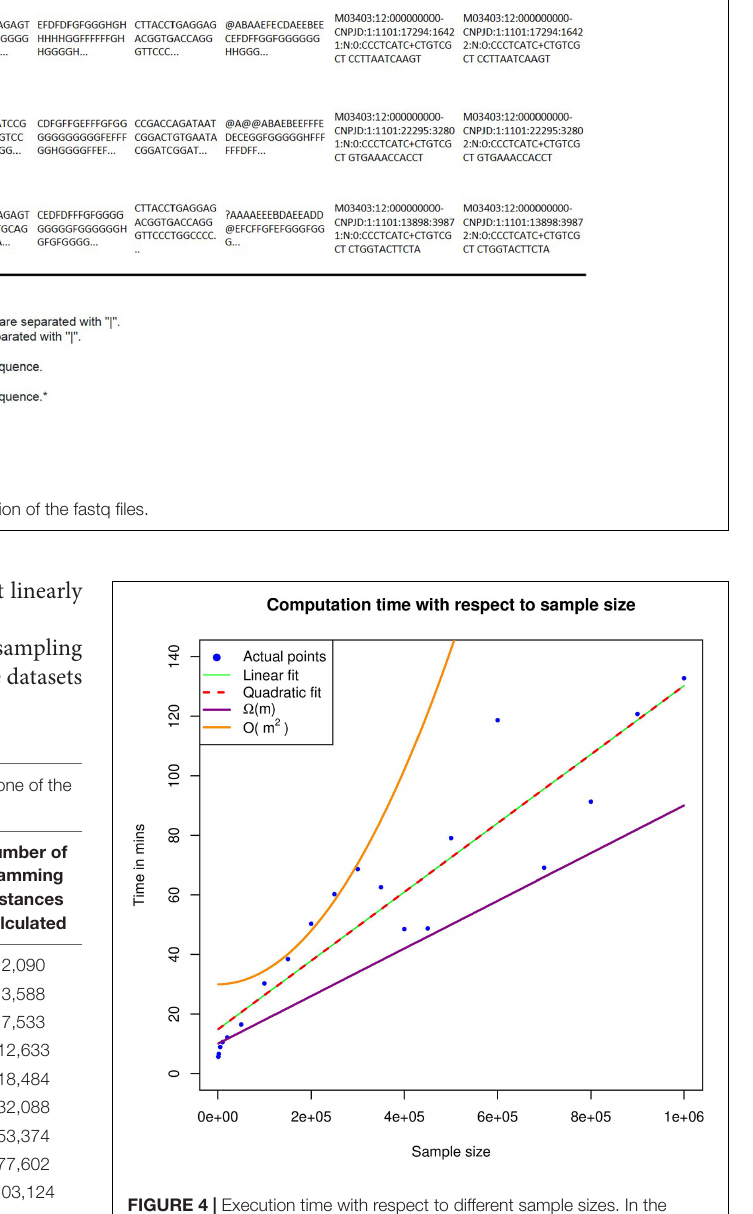
FIGURE 4 | Execution time with respect to different sample sizes. In the graph, the actual time points were fit to a linear and a quadratic function. Moreover, an upper and a lower bound of the estimated complexity is also